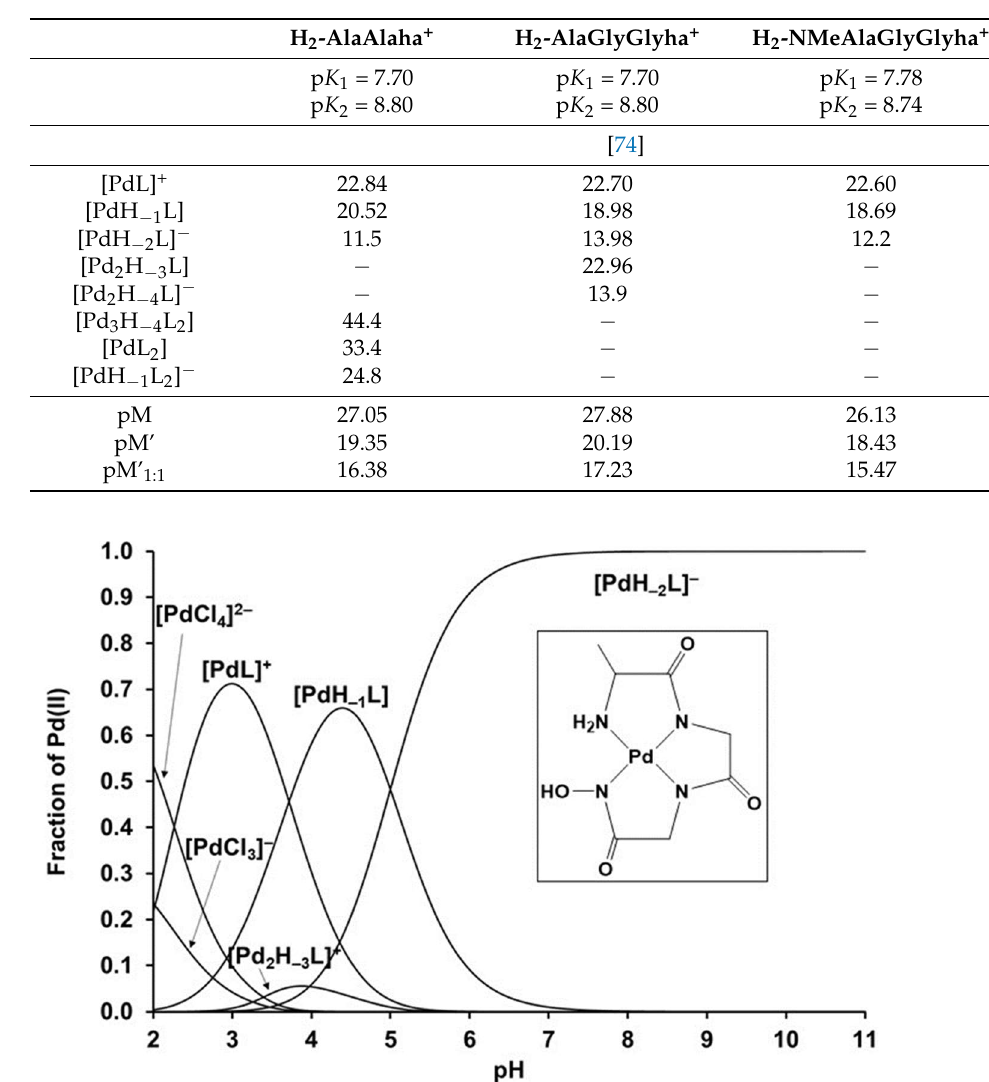
Figure 6. Concentration distribution curves calculated for the Pd(II)–H 2 -AlaGlyGlyha + system at a 1:1 ratio and the suggested structure of [PdH −2 L] − (c lig = 1.0